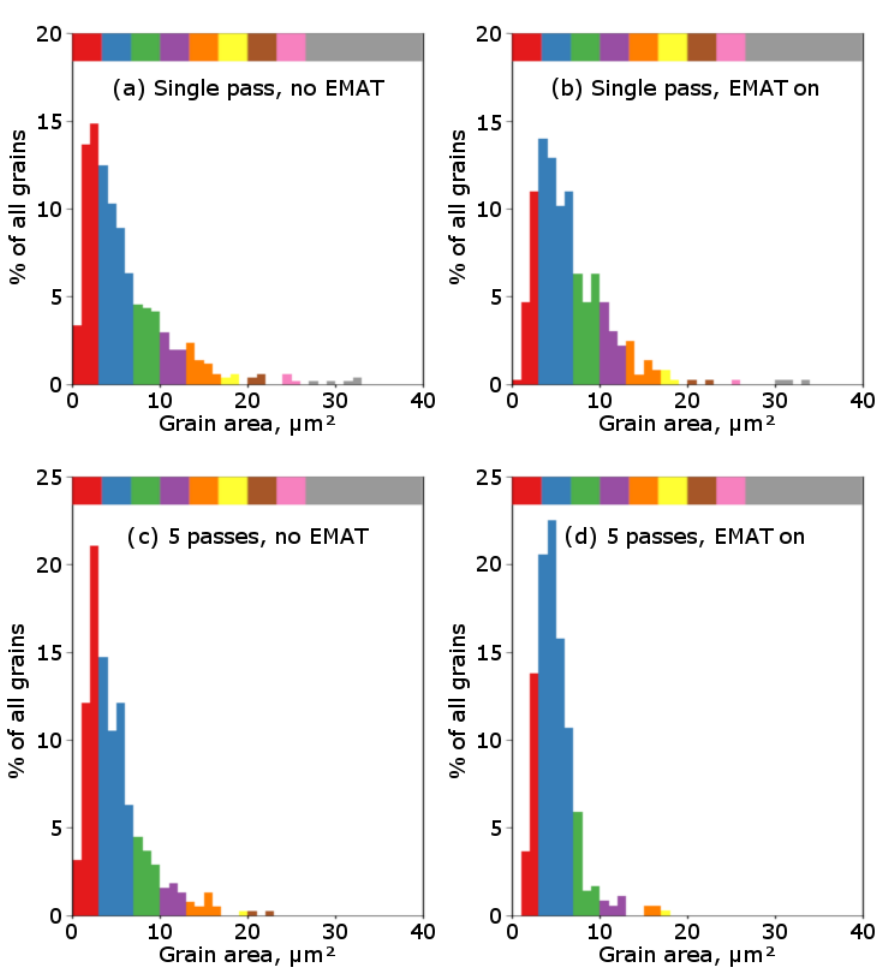
Figure 5. The distributions of micrograin sizes by their areas, ( a ) EMAT off, single pass; ( b ) EMAT on, single pass; ( c ) EMAT off, 5 passes; and ( d ) EMAT on, 5 passes. The same colors are used in Figures 3 and 4, where the grains are colored according to their size.